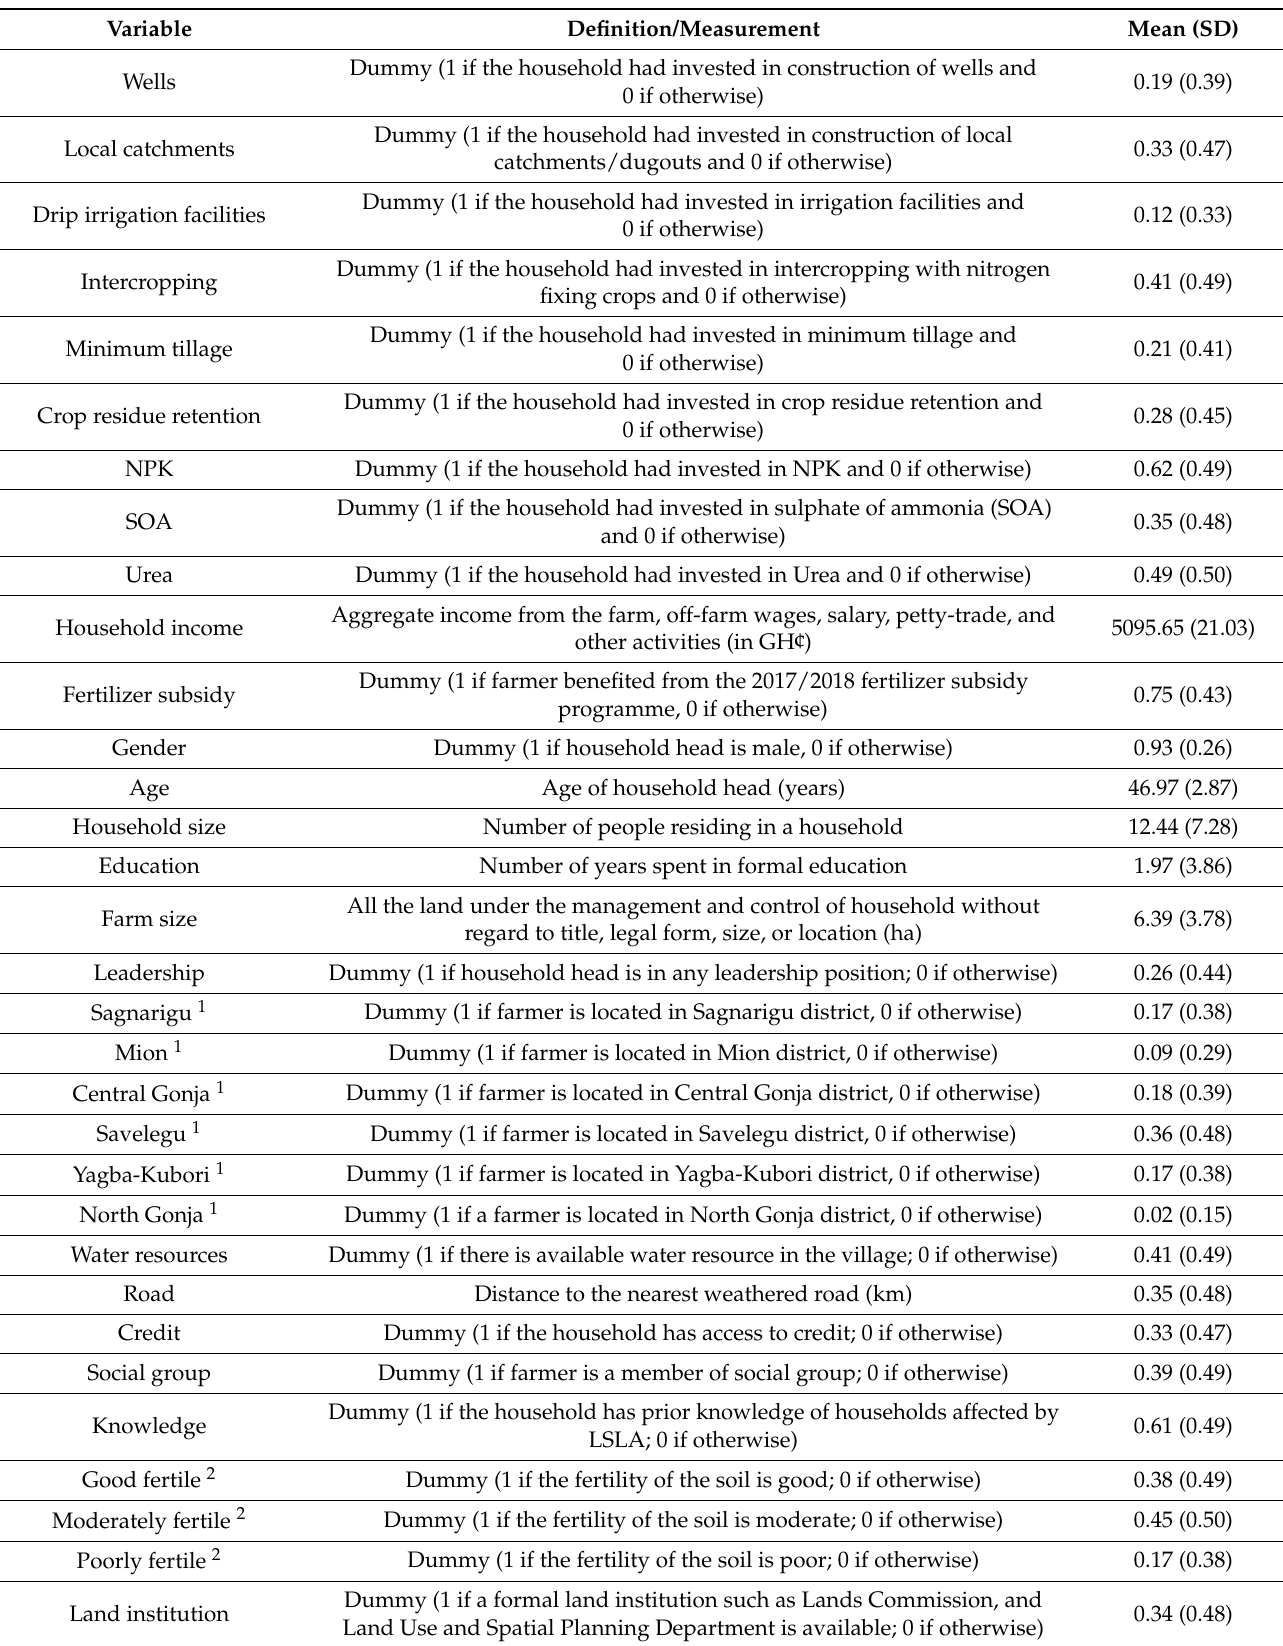
Table 2. Variable definition/measurement and a priori expectations.